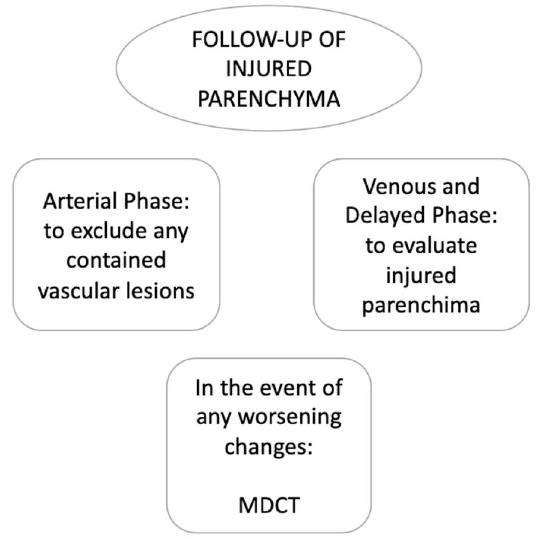
Figure 9. CEUS Figure 9. CEUS follow-up.